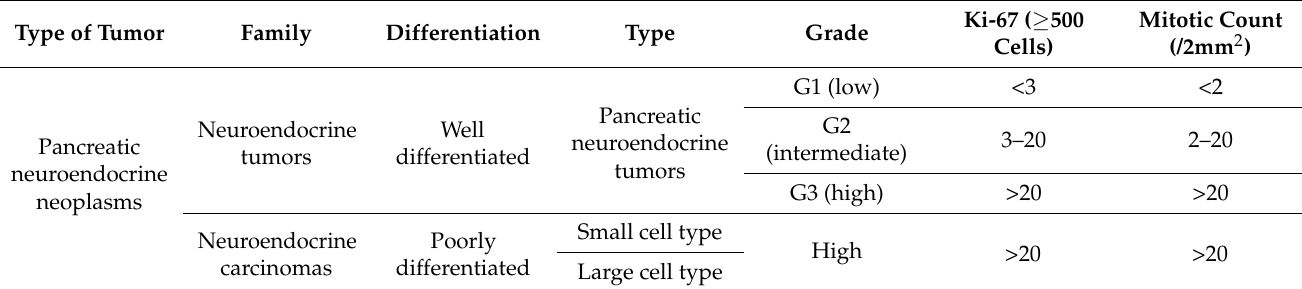
Table 1. PanNENs classification based on WHO 2010 and IARC